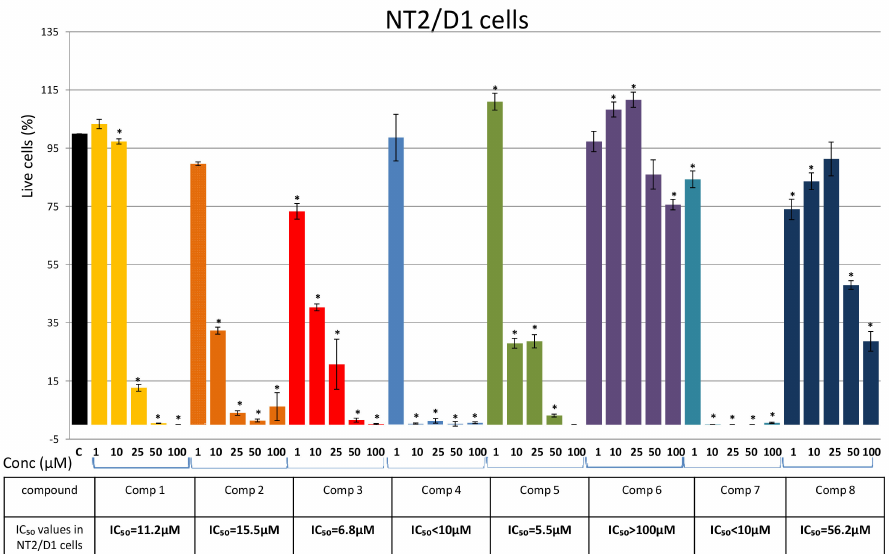
Figure 6. Effects of Compounds 1–8 on NT2/D1 cells. Cells were treated for 48 h with increasing concentrations (1 µ M, 10 µ M, 25 µ M, 50 µ M, and 100 µ M) of the tested compounds and cell viability was assessed using an MTT assay and expressed as the percentage of absorbance relative to the vehicle control (NT2/D1 cells treated with DMSO), which was set at 100%. Data are presented as the mean ± SEM of at least three independent experiments. An asterisk denotes a significant difference from the control (* p < 0.05). SEM—standard error of the